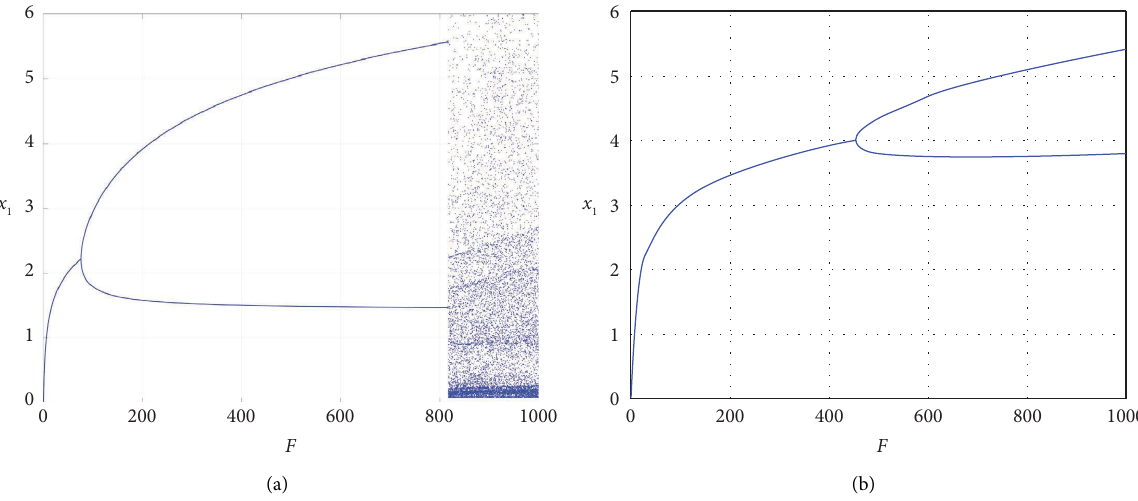
Figure 2: Bifurcation diagram generated by map (1): (a) ( μ